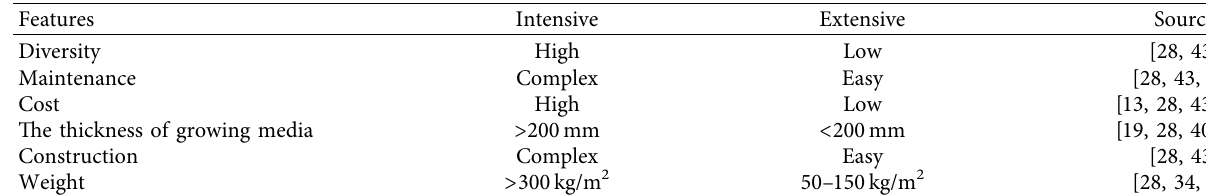
Table 6: The comparison between intensive and extensive systems.